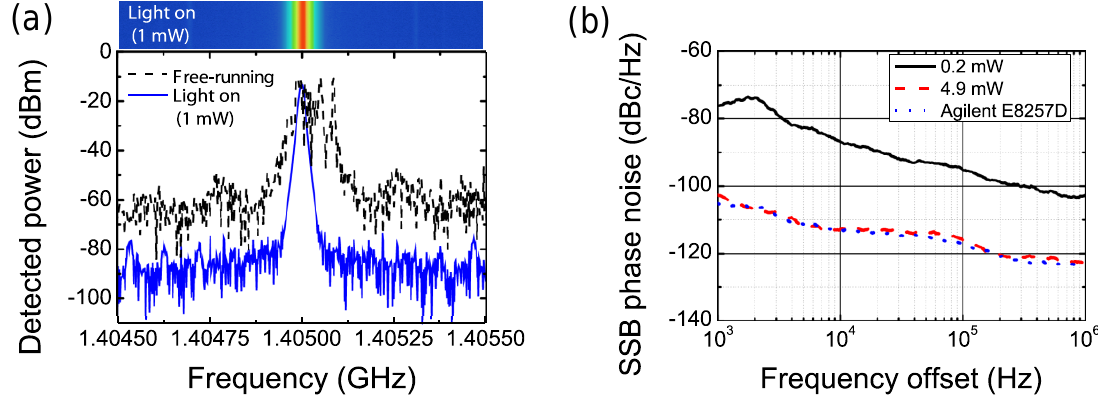
Figure 6. ( a ) Power spectra of the free-running and locked signals. ( b ) Single side band phase noise